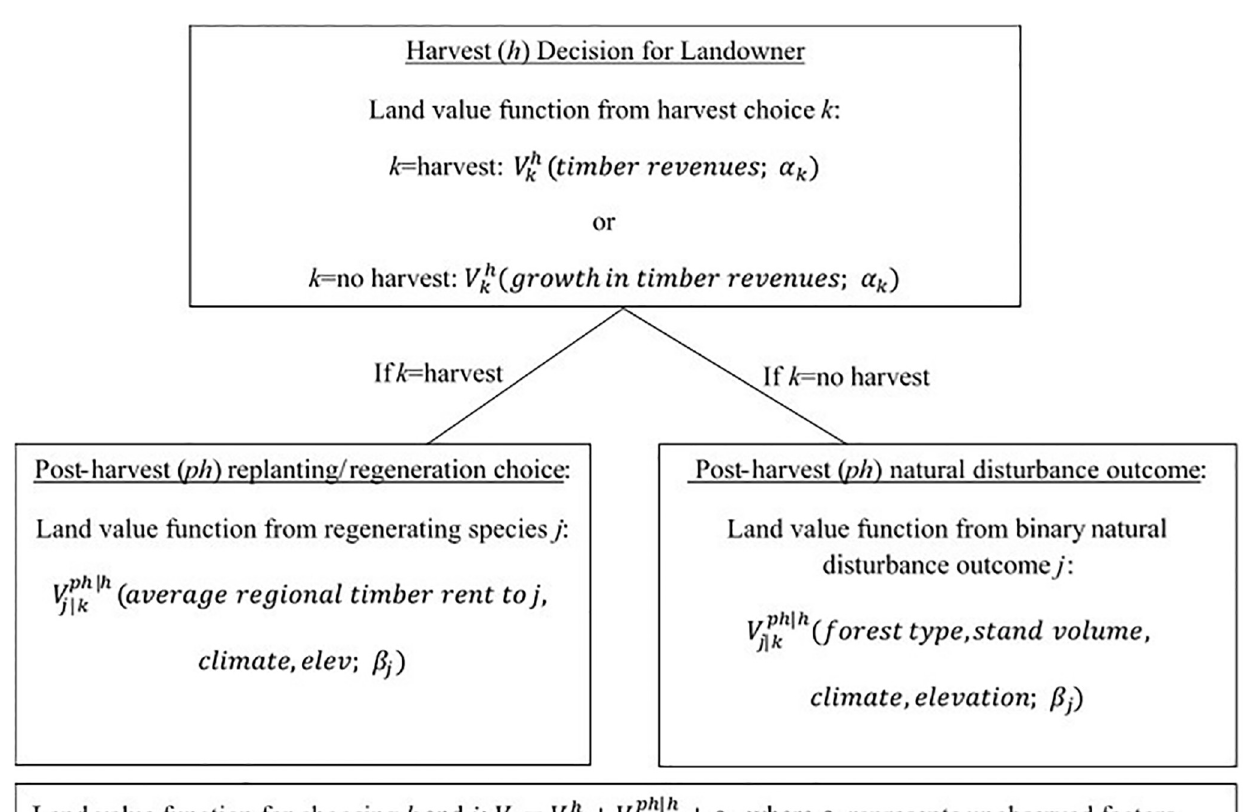
Fig 2. Schematic of econometric model of forest management. Estimation is based on the principle that landowners choose forest management to maximize their economic land value. Parameter vectors α , β are estimated in Hashida and Lewis [3].